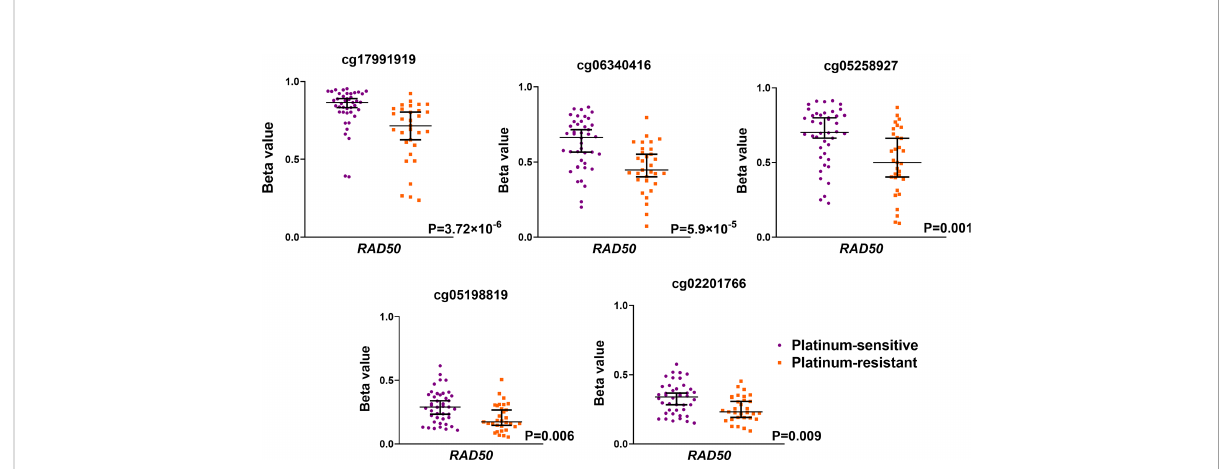
FIGURE 3 Signi fi cantly differentially methylated probes covering RAD50 gene as estimated using In fi nium MethylationEPIC BeadChip microarrays. EOC patients were divided as platinum-sensitive (N = 43, purple color) and platinum-resistant (N = 30, orange color) based on the platinum resistance status determined by platinum-free interval (PFI).